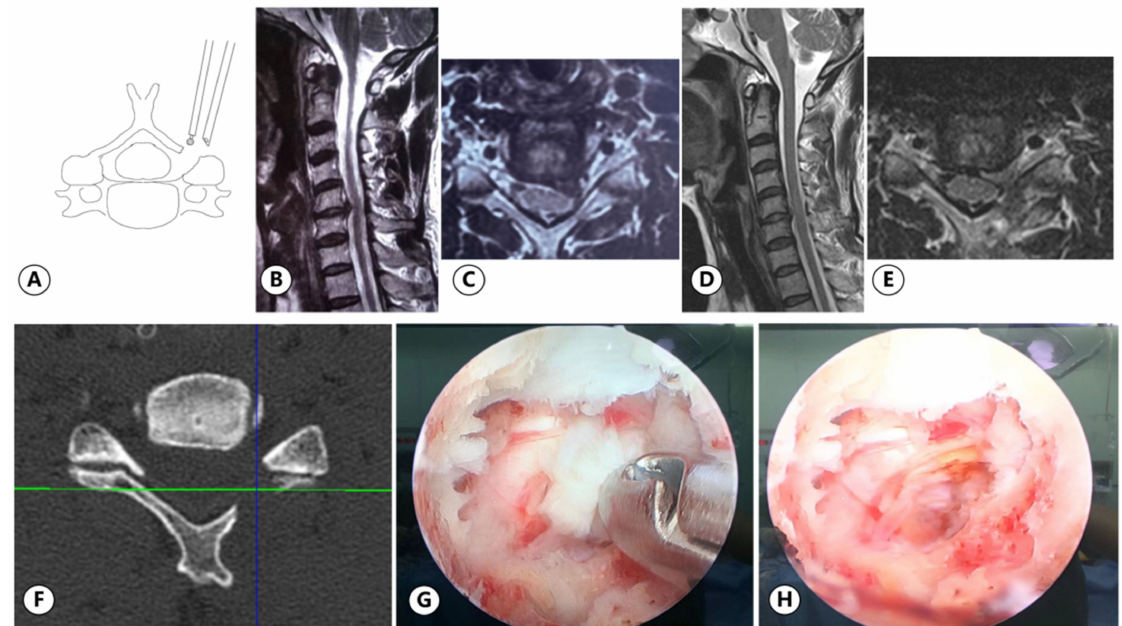
Figure 7. ( A ) Typical case of UBE surgery: a 51-year-old female with neck pain accompanied by radiating pain of left upper limb for five years and aggravated pain for six months. UBE operation diagram. ( B , C ) The preoperative MRI images. ( D , E ) The postoperative MRI images. ( F ) The postoperative CT image revealed the range of bony decompression. ( G ) The nucleus pulposus was removed during surgery. ( H ) The nerve root decompression was